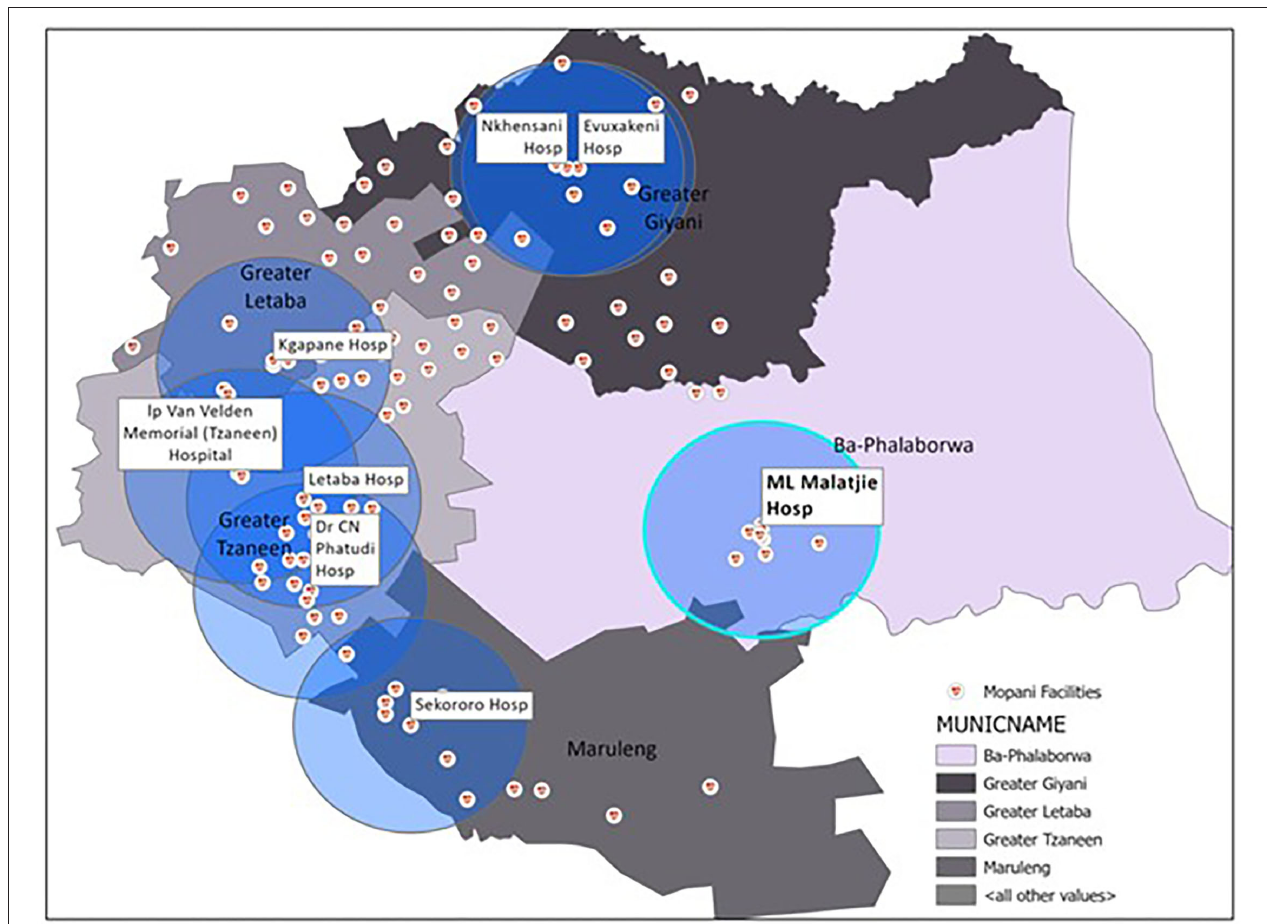
FIGURE 1 | Health facilities in Mopani